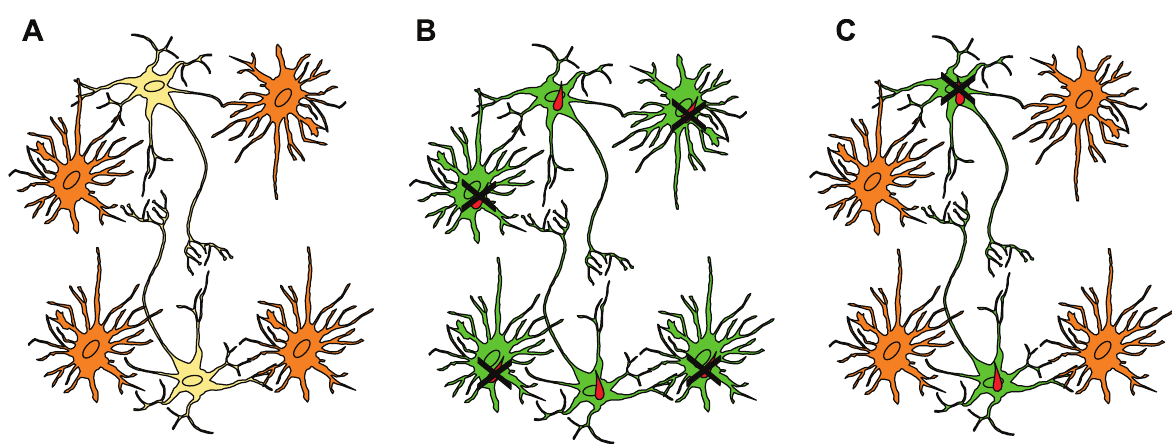
Fig 2. Using the Toxoplasma gondii –Cre systemto test 2 models of why T . gondii primarily persists in neurons in vivo. (A) After enteringthe CNS, T . gondii should be able to interact with different cells in the brain, includingboth astrocytes (orange)and neurons(beige). As the T . gondii –Cre system leads to the expressionof a green fluorescent protein (GFP) in host cells injected with T . gondii protein regardlessof infection status, it can help distinguish between2 likely models for T . gondii persistencein neurons. (B) Model 1: after infiltrationof the CNS, T . gondii interacts with and invades both astrocytes and neurons, causingboth cell types to express GFP (green). Astrocytes clear the intracellularparasite whileneuronscannot, leavingneuronsas the primary host cell for persistent infection. (C) Model 2: after infiltrationof the CNS, T . gondii almost exclusivelyinteracts with and invadesneurons, leadingto GFP expressionprimarily in neurons. Neuronspotentiallyclear some but not all invadingparasites, leavingneuronsas the primary host cell for persistent